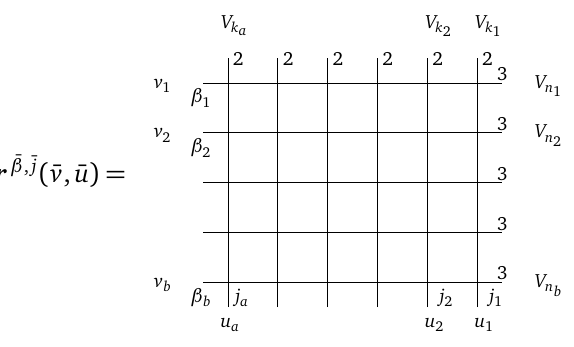
Figure 5: Graphical interpretation of the matrix element r ¯ β ,¯ j ( ¯ v , ¯ u ) .